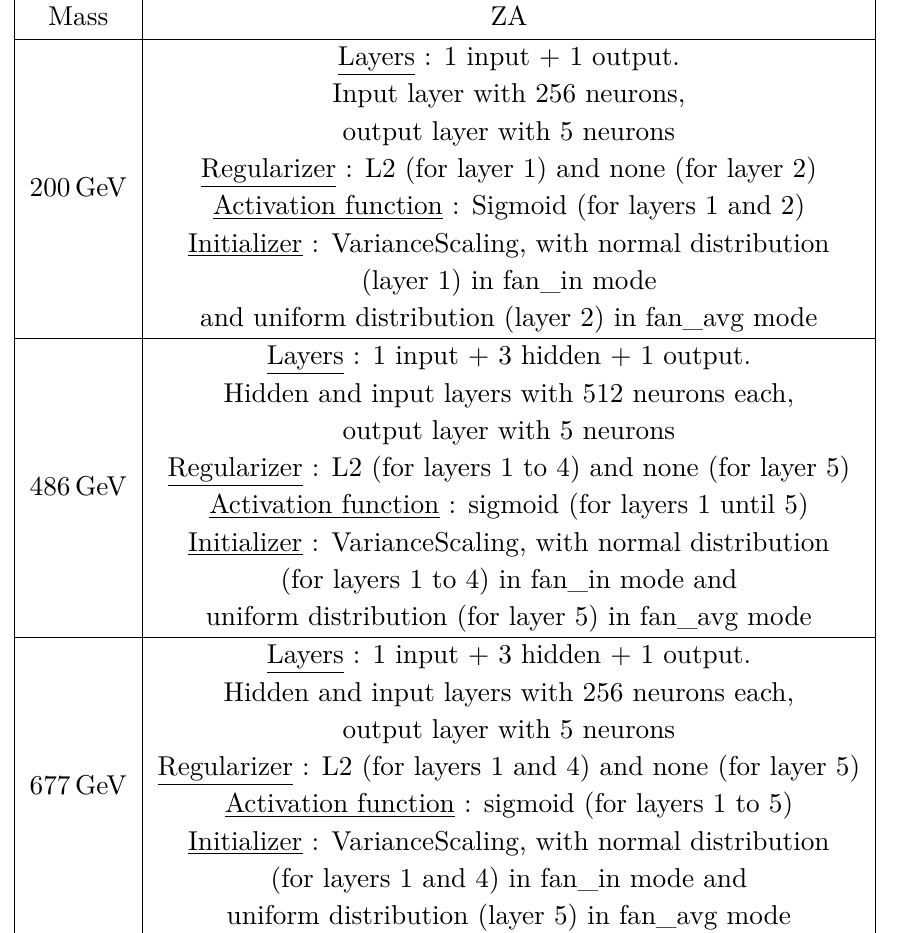
Table 13. Neural networks architectures employed for each mass of the lightest VLL for ZA. The architecture is determined following the implementation of an evolutive algorithm that maximises the Asimov